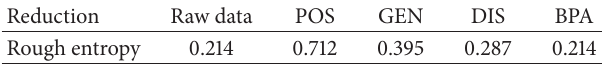
Table 5: The uncertainty measure of five relative